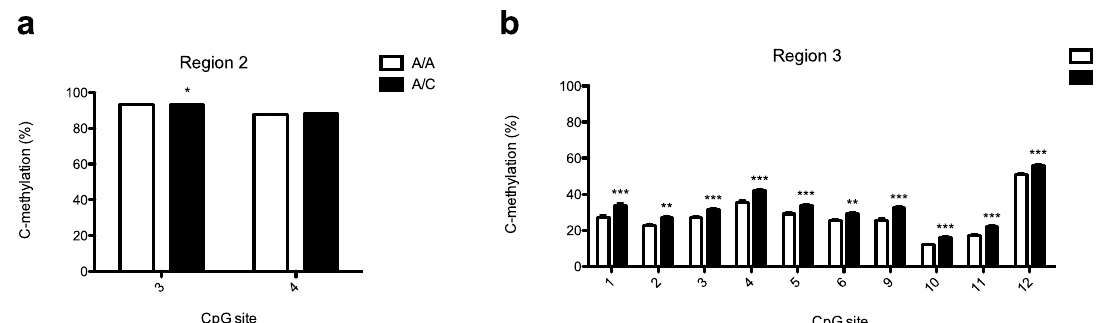
Fig 3. Methylation proportions in region 2 and 3 in blood from healthy individuals. Methylation proportions as determined by pyrosequencingof region2 and 3 in blood from healthyindividuals.Methylationproportions were measured by pyrosequencing of region2 and 3 in DNA extracted from blood obtainedfrom healthy females being either homozygous (A/A) or heterozygous (A/C) for SNP rs138880.The assay designed for region2 allowedconfirmation of the rs138880 genotype. Data are presented as mean cytosine methylationproportions (C-methylation) at each CpG site +SEM (n = 24/group). * p < 0.05, ** p < 0.01, *** p < 0.001,